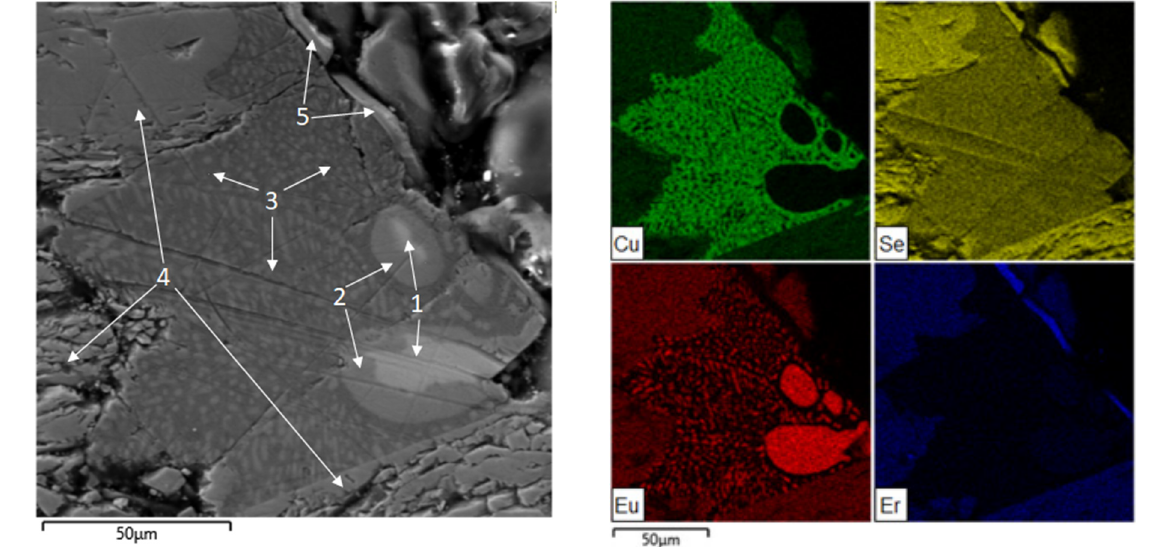
Table 5. Temperatures and enthalpies of melting of EuLnCuSe 3 compounds. Compound